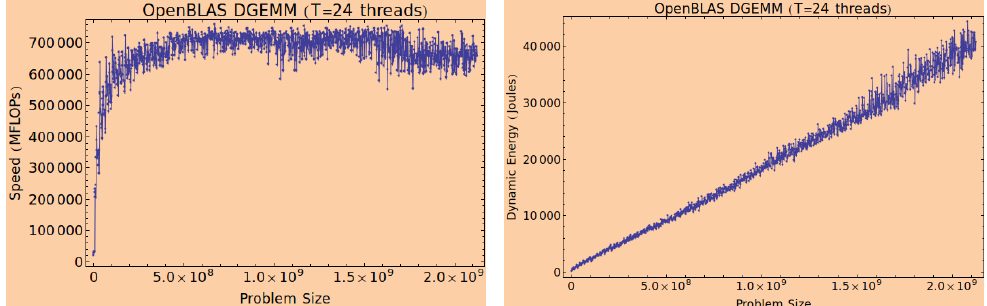
Figure 5. The speed and dynamic energy consumption profiles for the OpenBLAS DGEMM applica- tion employing 24 threads on the Intel Haswell multicore CPU are shown in Figure 1. The application multiplies two matrices of size x × n and n × n where n is 46,080. The problem size in the figure is x × n . The workload size 2 × x × n 2 is proportional to the problem size (since n is kept constant). Note the non-linear profile shapes in the plots are observed for many matrix sizes. We have selected one matrix size ( n = 46,080) only for illustration.